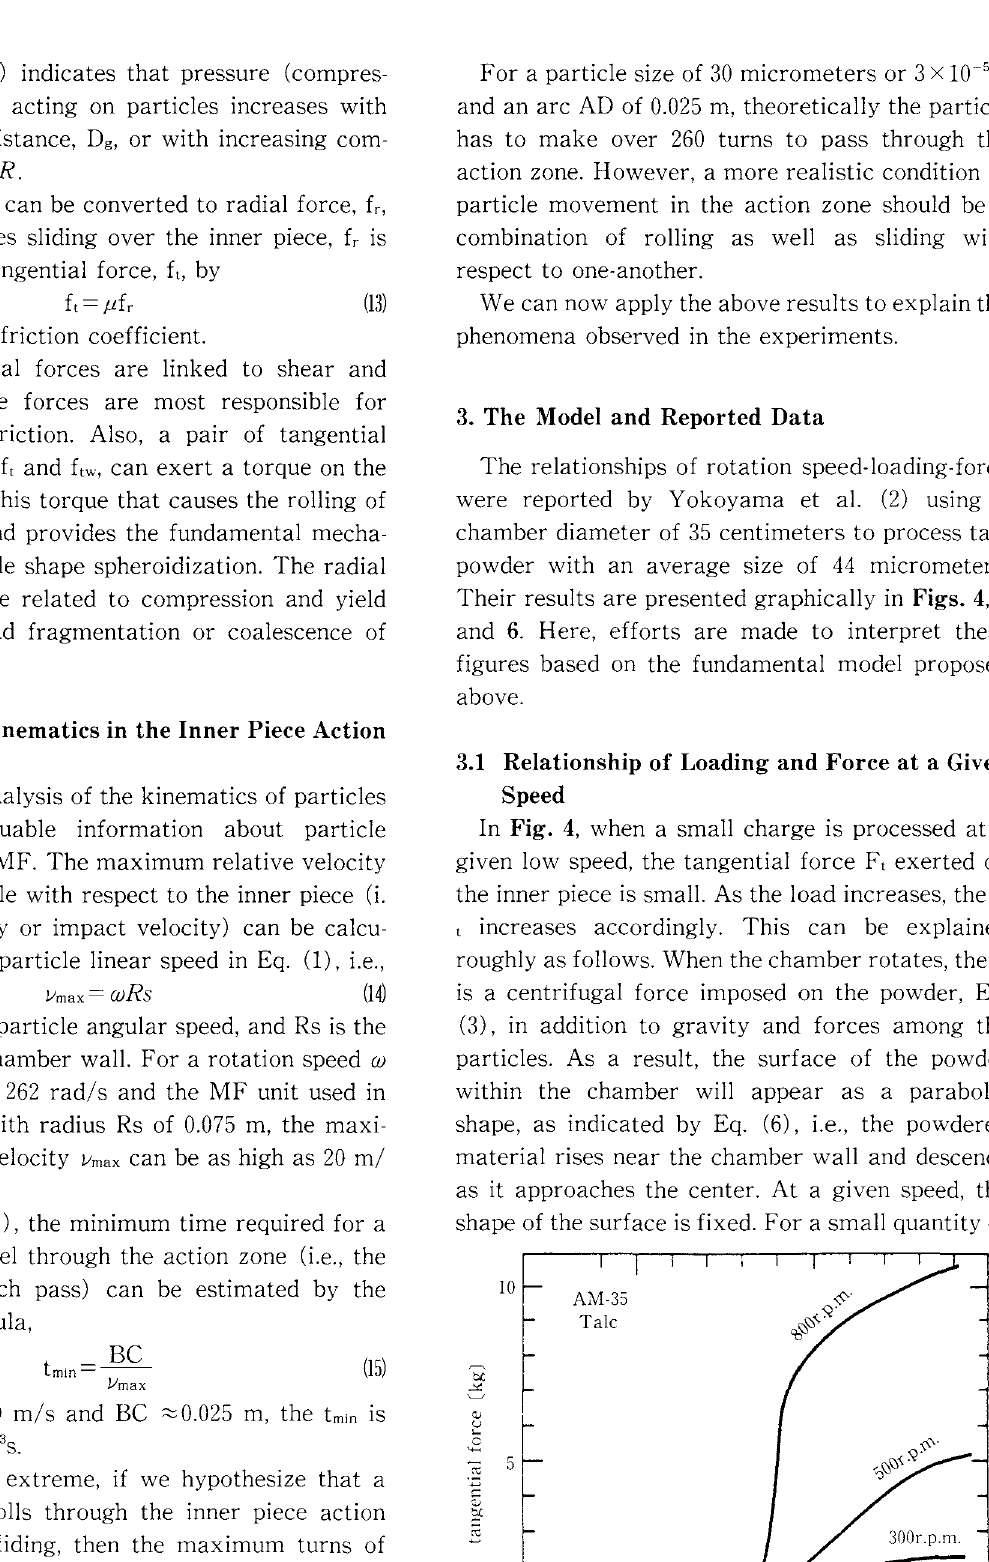
Fig. 4 Variation of the tangential force acting on the inner piece tip with loading weight and rotation speed (2).